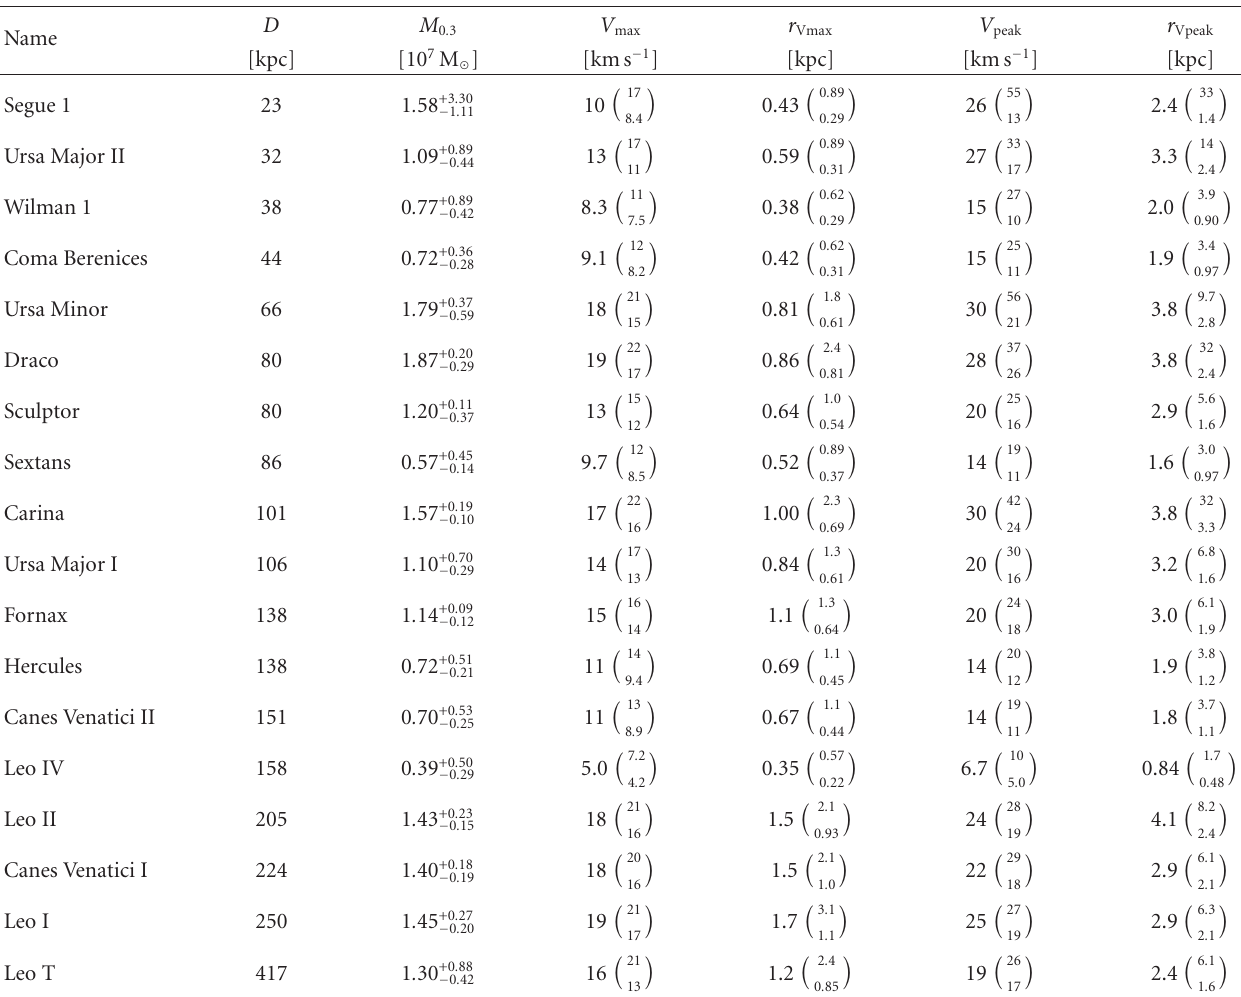
Table 1: The properties of likely DM subhalos of the 18 Milky Way dSph galaxies for which M 0 . 3 values (column 3) have been published [33]. V max and r Vmax are the maximum circular velocity and its radius, V peak and r Vpeak the largest V max a subhalo ever acquired and its corresponding radius. The first number is the median over all Via Lactea II subhalos matching the dSph’s distance and M 0 . 3 , the numbers in parentheses the 16th and 84th percentiles (see text for